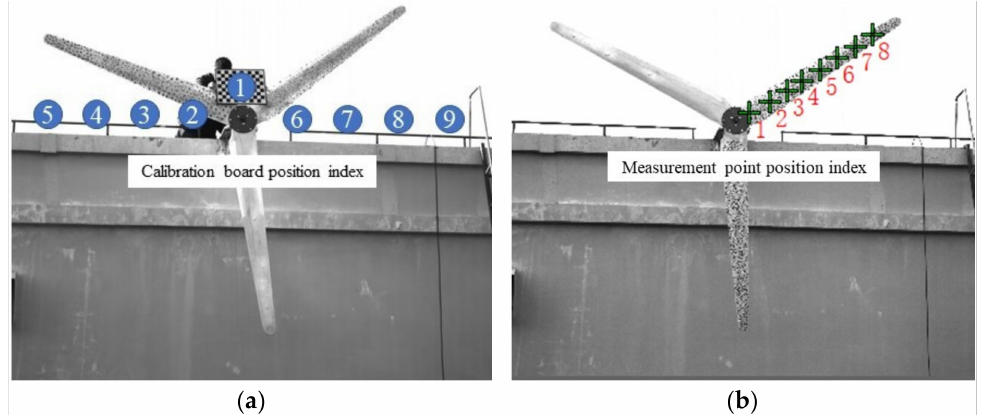
Figure 14. ( a ) Placement of calibration board; ( b ) selected features on the blade.